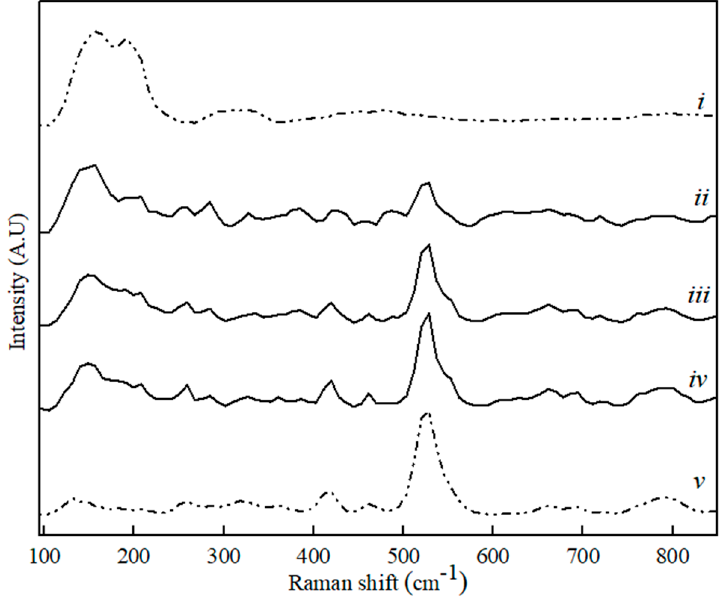
Figure 5. Raman spectra for CaS ( i ), CA ( v ) and binary CA–CaS phase sample with CaS content, where ( ii ) 80 wt. %, ( iii ) 60 wt. %, and ( iv ) 20 wt. %.